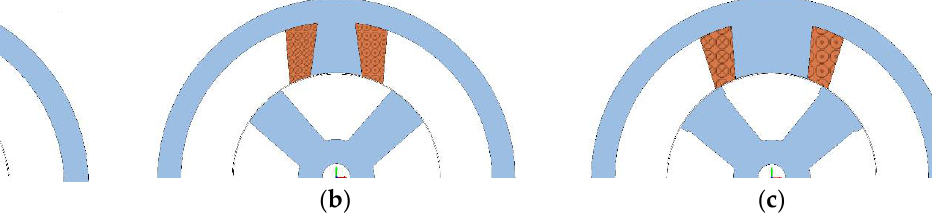
Figure 18. ( a ) First optimal design; ( b ) second optimal design; ( c ) trade-off design. Table 4. Optimal designs according to the Taguchi SA.